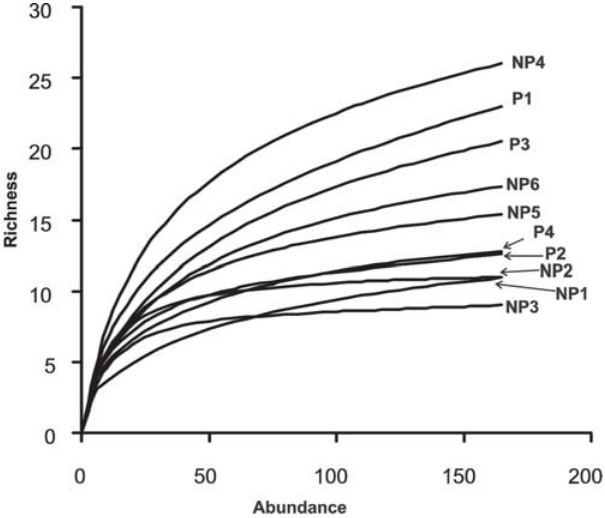
Fig. 2. Fish assemblage rarefaction plot by stream stretches. P1 = Macaúba; P2 = Carapina; P3 = Barreiro; P4 = Cana Brava; NP1 = Palmito; NP2 = Onça; NP3 = Unnamed Stream 3; NP4= Bandeira; NP5 = Pedreira; NP6 = Unnamed Stream 2.